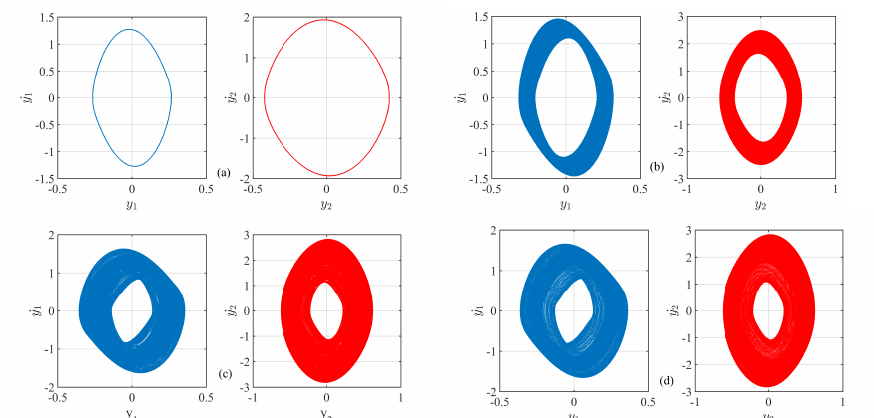
Figure 7. The phase portraits of the considered system for different values of ω nd . x -axis is the non-dimensional displacements y 1 , y 2 and the y -axis is the non-dimensional velocities ˙ y 1 , ˙ y 2 , re- spectively. The left and the right sides of each figure are the phase-portraits of each oscillator. ( a ) ω nd = 4.00, Period-1 orbit, ( b ) ω nd = 4.05, quasi-periodic orbit, ( c ) ω nd = 4.093, quasi-periodic orbit, ( d ) ω nd = 4.098, chaotic orbit. The parameters are: ζ 1 = 0.0868, ζ 2 = 0.1036, t 1 = 0.2413, t 2 = 0.288, b 1 = 45.7143, b 2 = 54.5737, a 1 = 5.8548 × 10 − 3 , D 1 = 1.5, β = 11.11, µ = 1.1938, δ 1 = 1. The initial condition has been chosen at (0.333,0,0,0). (Color Online).